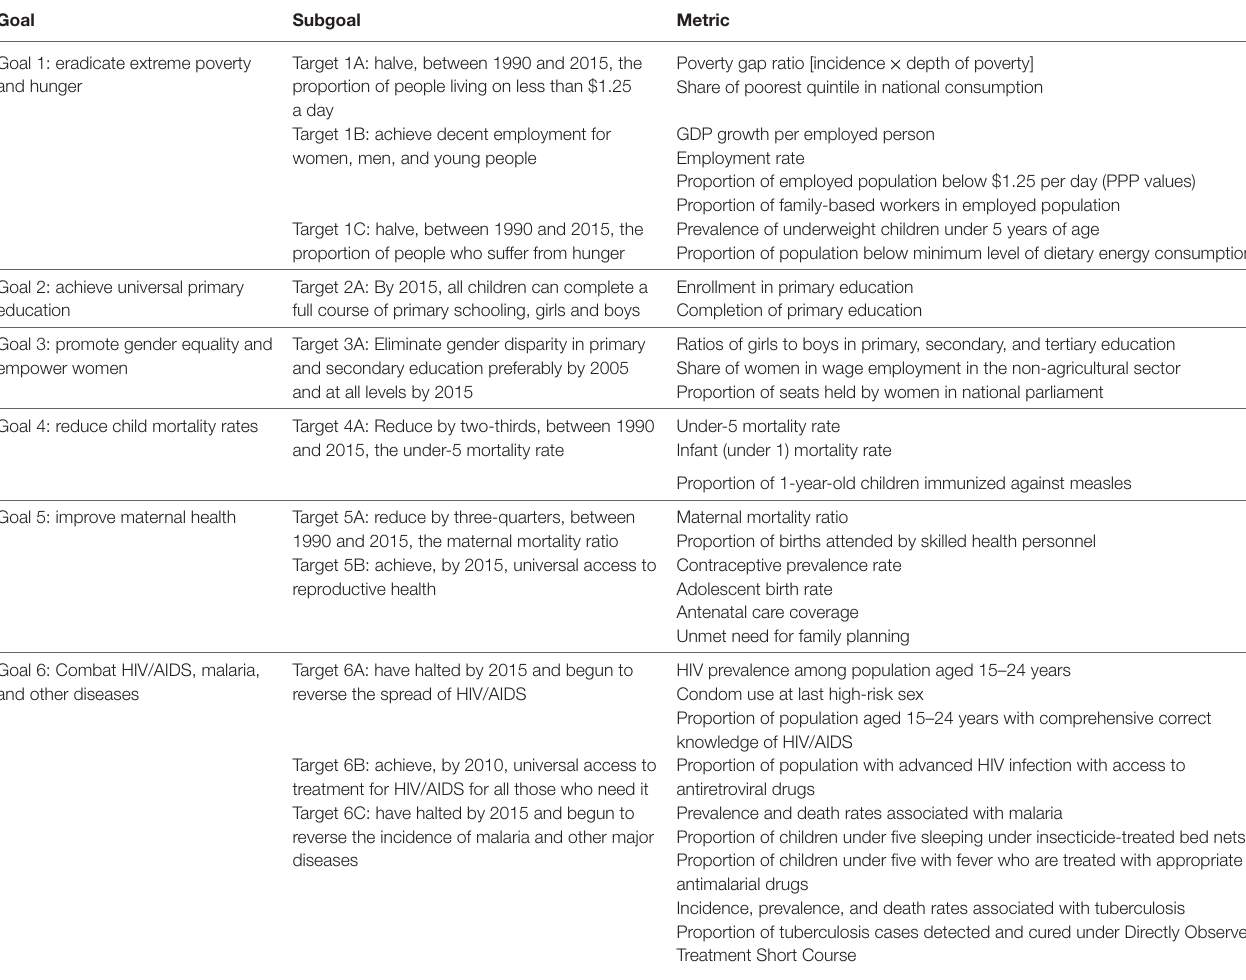
TABLe 5 | United Nations Millennium Goals related to child health assessment. Goal Subgoal Metric Goal 1: eradicate extreme poverty and